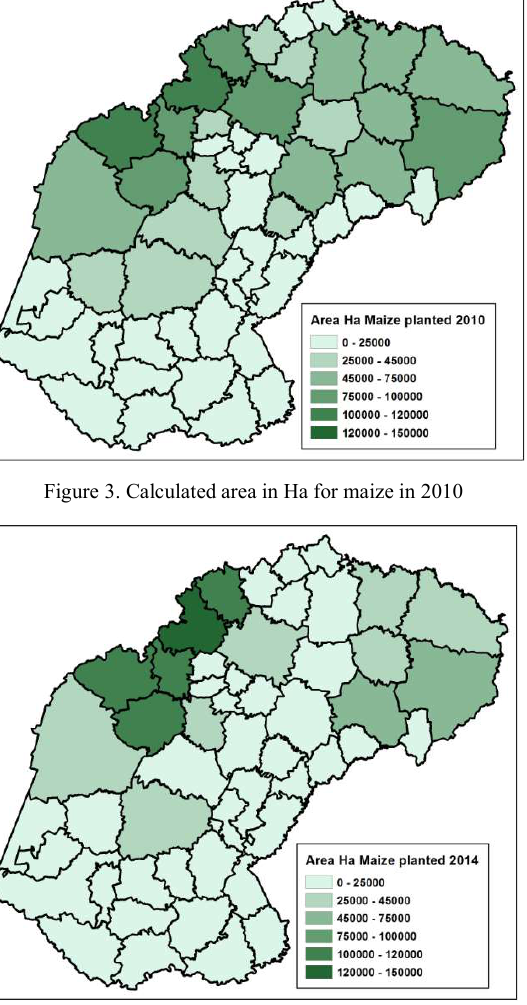
Figure 4. Calculated area in Ha for maize in 2014